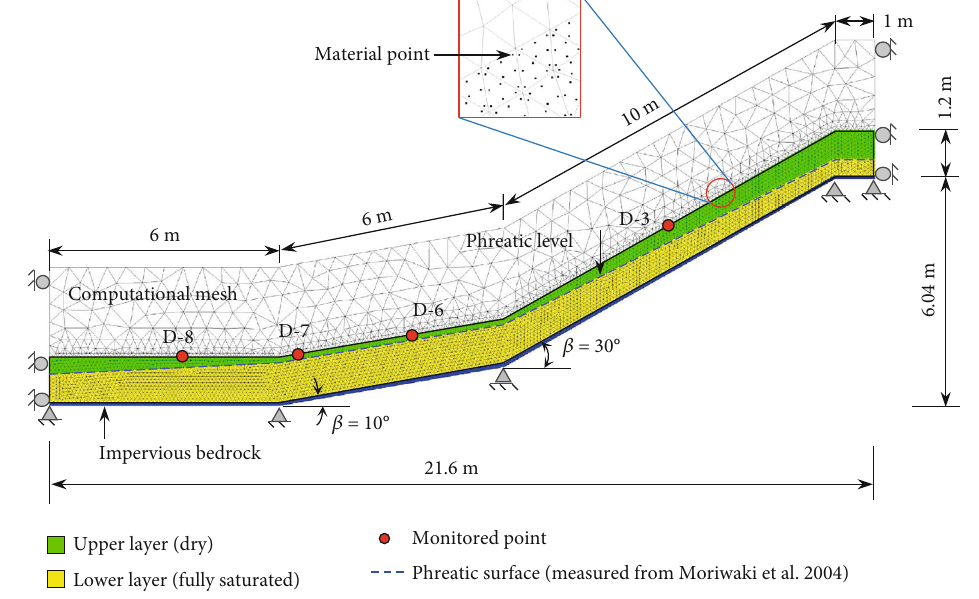
Figure 2: Initial geometry of the numerical model for the model validation. Table 1: Material properties for numerical model